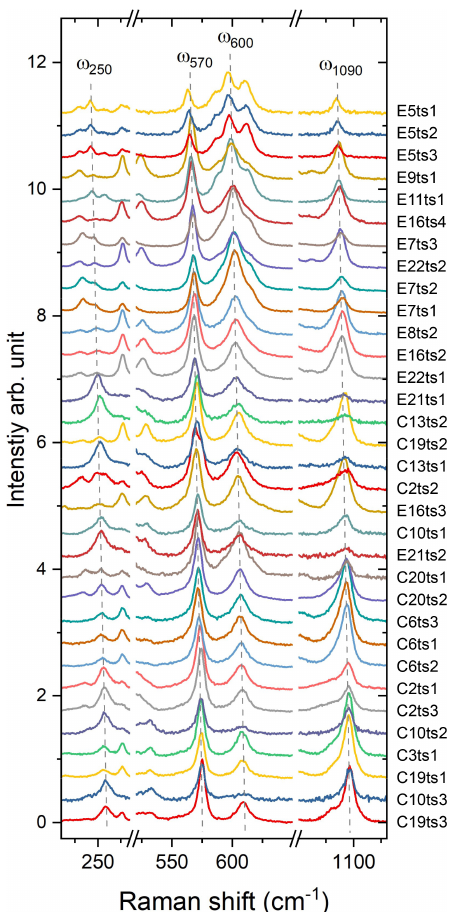
Figure 7. Raman spectra showing on an enlarged scale the peaks ω 250 , ω 570 , ω 600 , and ω 1090 . The Fe content increases from the bottom to the top. For better comparison, the spectra were normal- ized to the height of the strongest peak and vertically